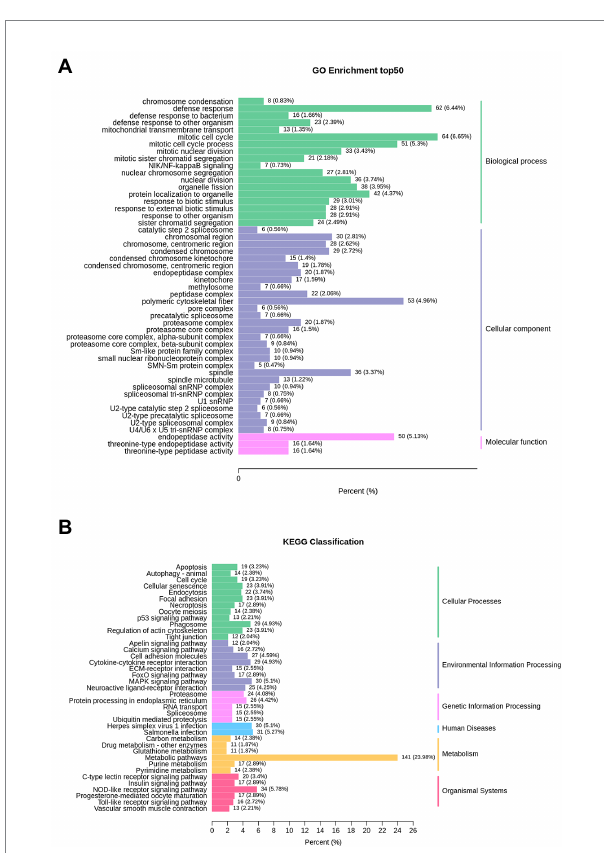
FIGURE 3 Enrichment column diagram of DEGs after infection with Aeromonas hydrophila. (A) GO enrichment analysis of DEGs after infection. (B) KEGG enrichment analysis of DEGs after infection.